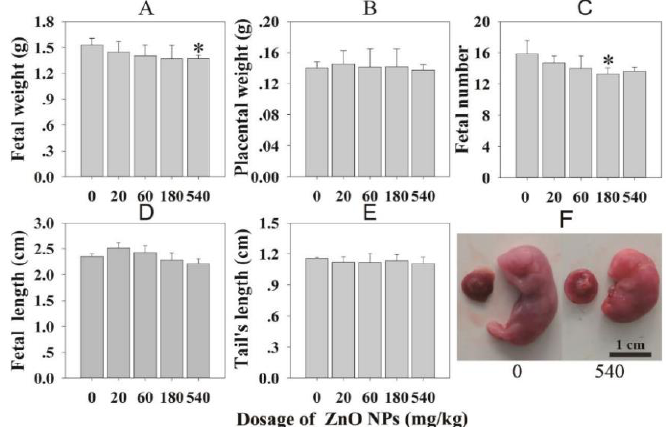
Figure 43. Fetal development in pregnant mice upon oral exposure to ZnO NPs. ( A ) Fetal weight, ( B ) placental weight, ( C ) fetal number, ( D ) fetal length, ( E ) tail length, and ( F ) fetal image showing fetus body malformation in pregnant mice treated with 540 mg/kg ZnO NPs. The data are expressed as mean ± SD (n = 60); * p < 0.05 vs. control. Reproduced from [189] under the Creative Commons Attribution license.